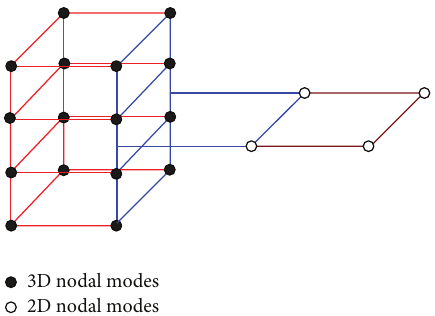
Figure 3: Connection between two- and three-dimensional ele-